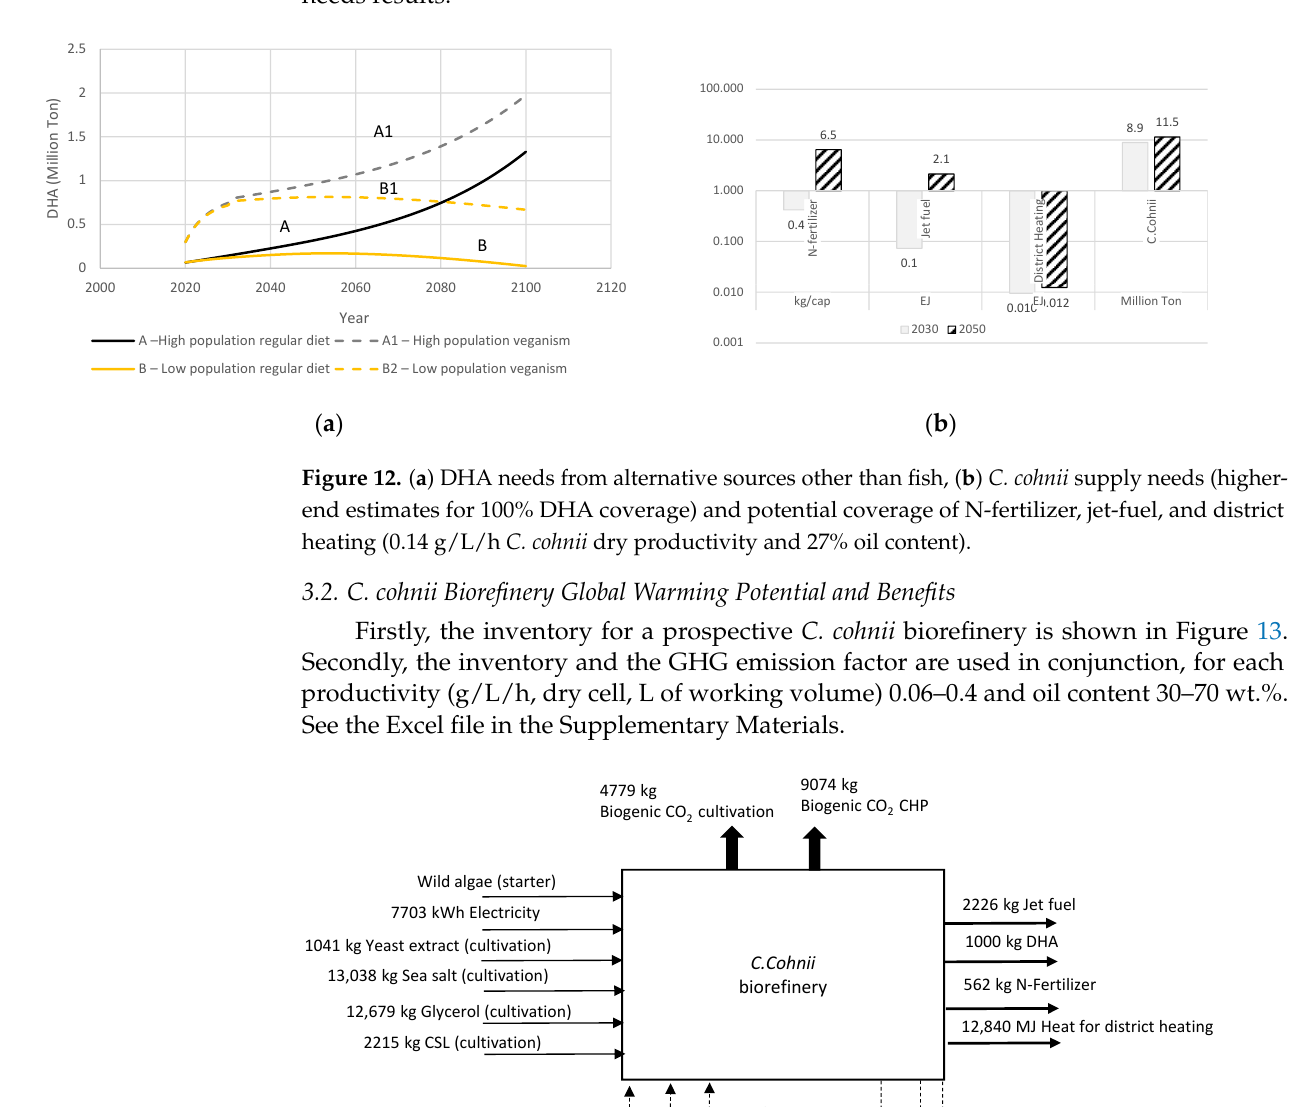
Figure 13. Inventory overview for 1 ton DHA, 0.14 g/L/h C. cohnii dry productivity and 30% oil content (used for TEA analysis, see Section 3.4).